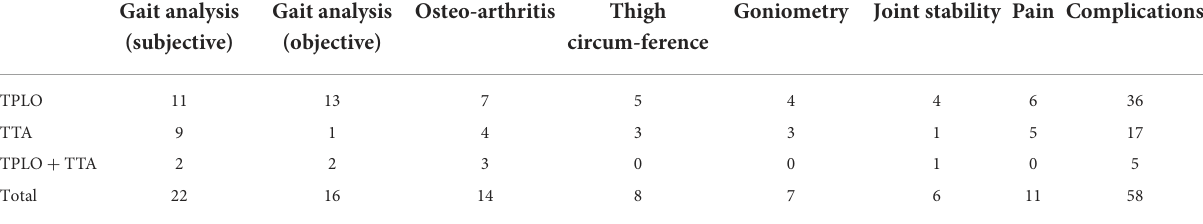
TABLE 2 Outcome